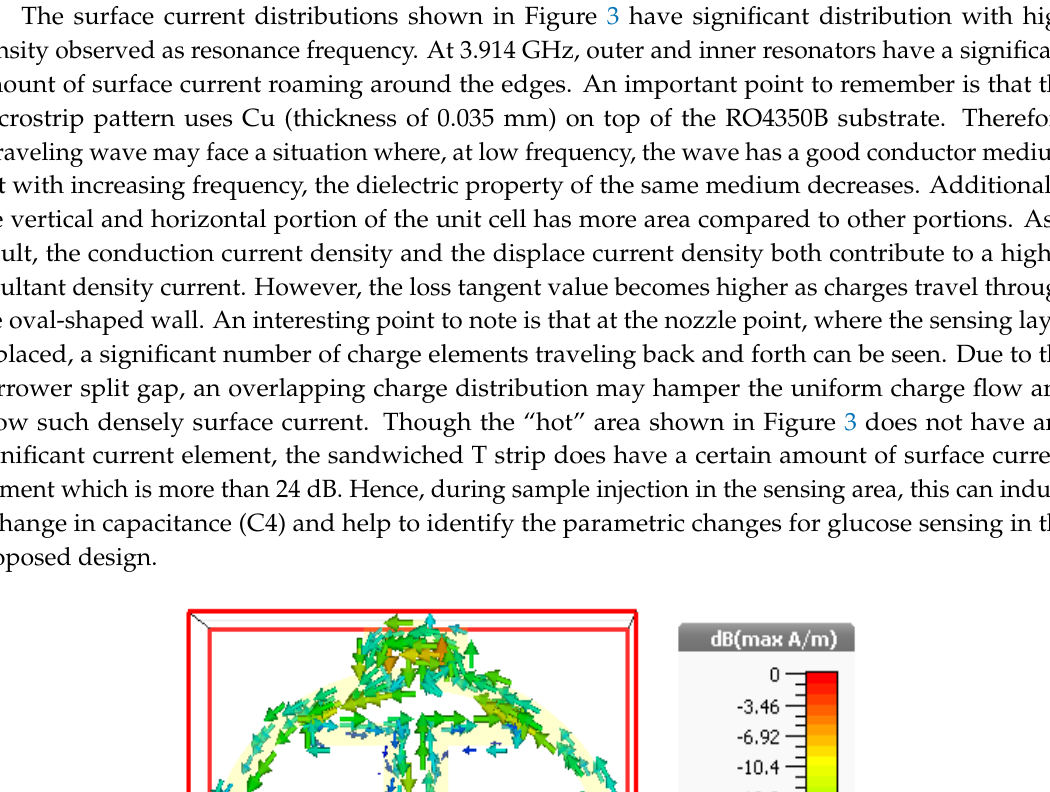
Figure 2. At resonance frequency (3.914 GHz), the ( a ) E-field distribution; ( b ) H-field distribution.